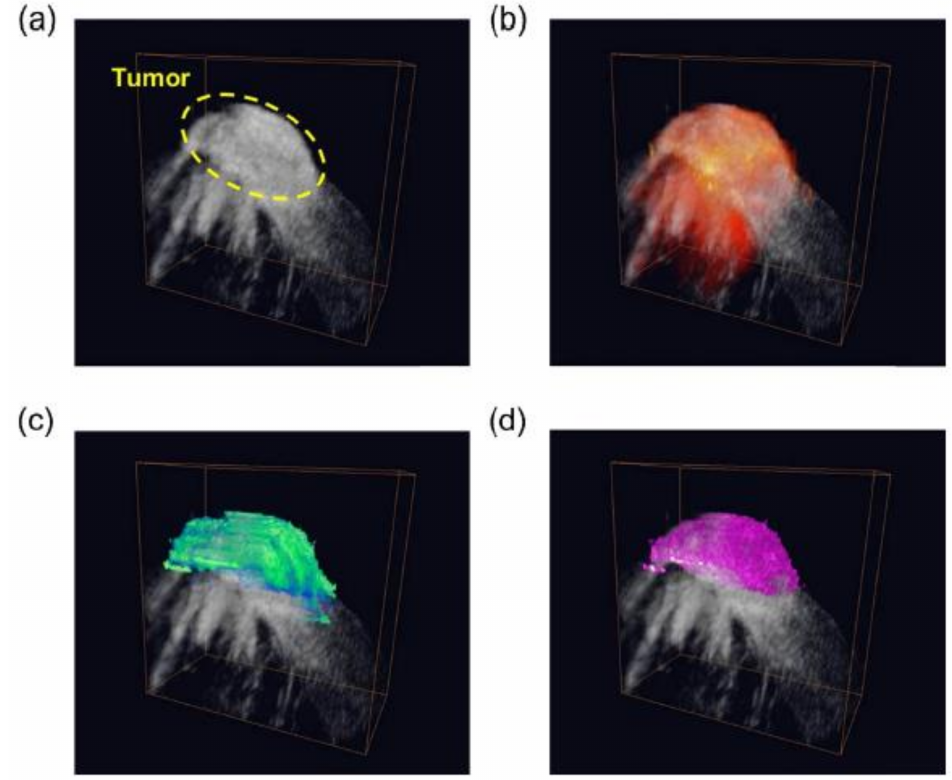
Figure 21. 3D ( a ) ultrasound, ( b ) photoacoustic, ( c ) magneto-motive ultrasound, and ( d ) magneto- photo-acoustic images of the LNP accumulated in the tumor area and the background tissue in a mouse. Figure adapted from [156], Copyright 2014 Elsevier